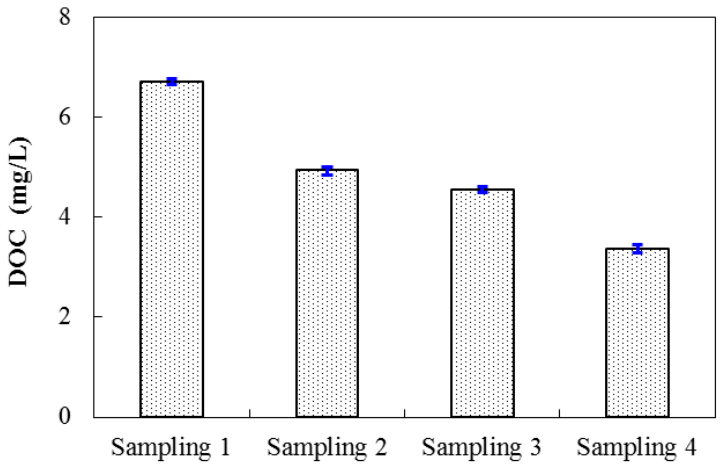
Figure 3. The removal of overall DOC across the water treatment process (from Figure 1, Samplings 1–4 represented the water sampling from raw water, after the CTP, ozone and BAC). The presented data in the figure are the average of the observations (n = 3); the error bars represent the standard deviation of replicate measurements, and their relative standard deviation (RSDs) are all below 5%.